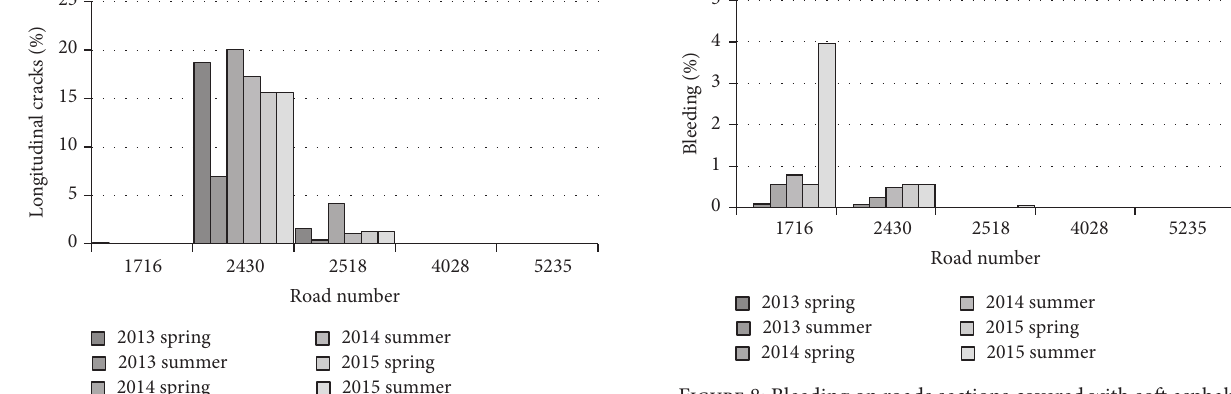
Figure 8: Bleeding on roads sections covered with soft